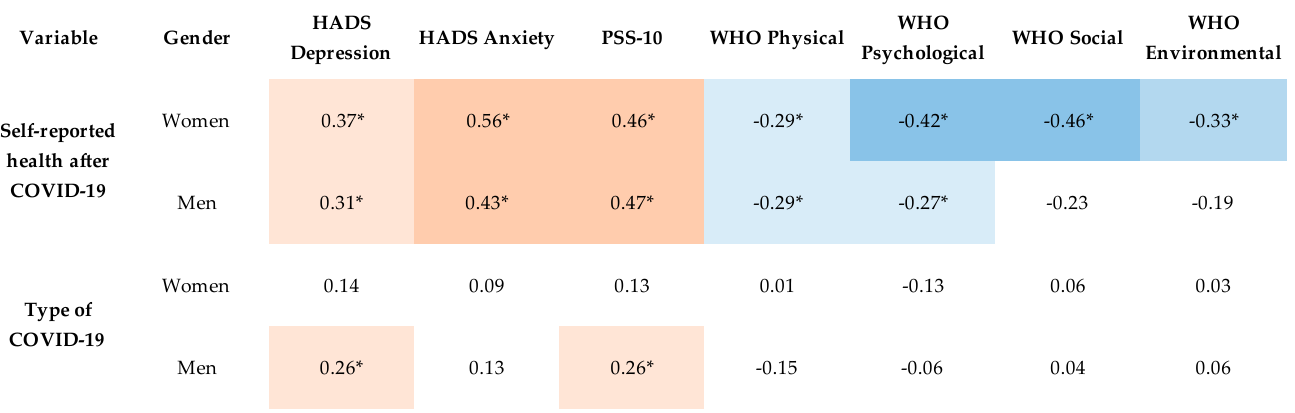
Figure 2. Spearman’s correlation heatmap. Significant correlation marked with asterisk. Note : Self ‐ reported health was coded hierarchically (good/fair/poor), and type of COVID ‐ 19 was coded hierarchically (asymptomatic/mild/moderate/severe).